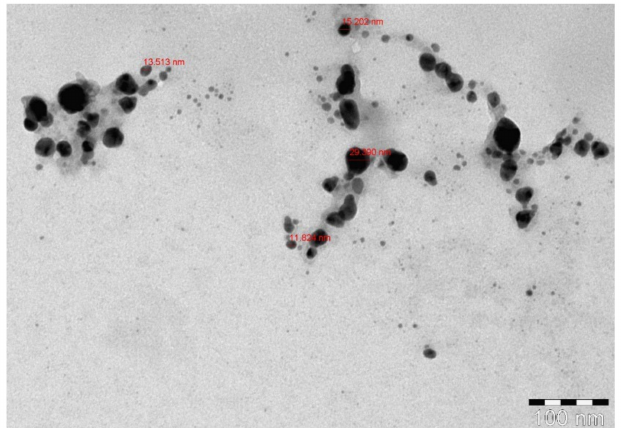
Figure 2. TEM micrograph of biosynthesized